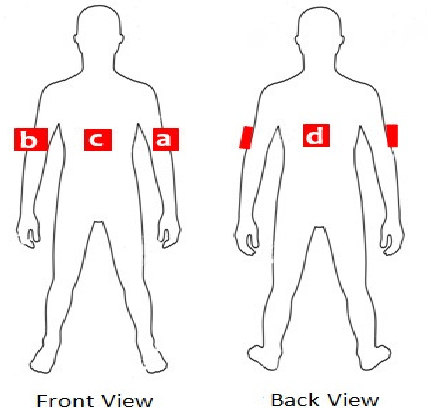
Figure 2. Conceptual view of tagged human. Front and back view of a human equipped with a tag array and red rectangles represent radio-frequency identification (RFID) tags labeled as a, b, c and d. These red rectangles also express the body places where RFID tags are attached.